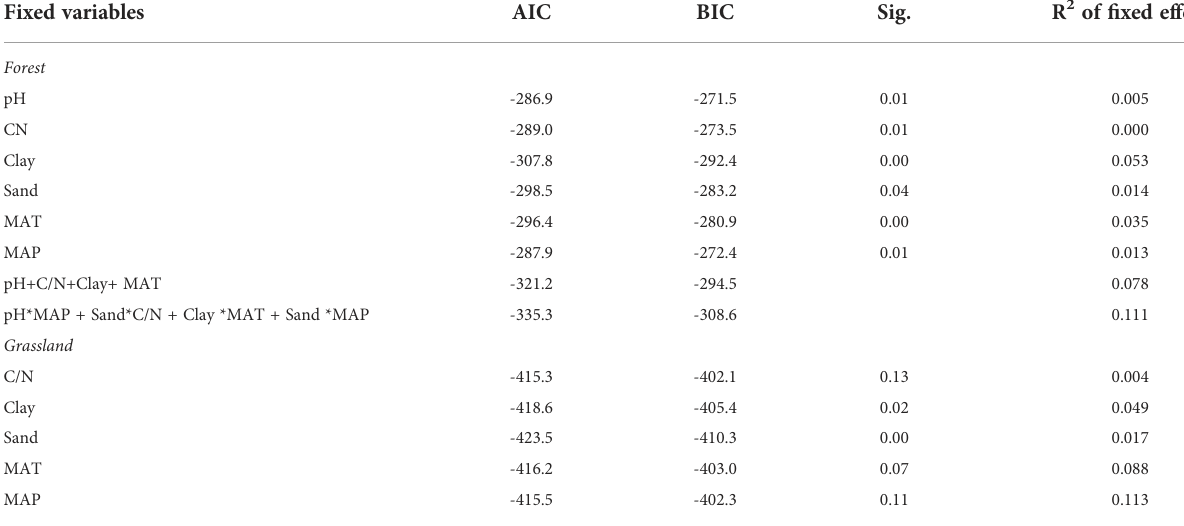
TABLE 3 AIC and BIC of mixed linear models with different continuous variables. Fixed